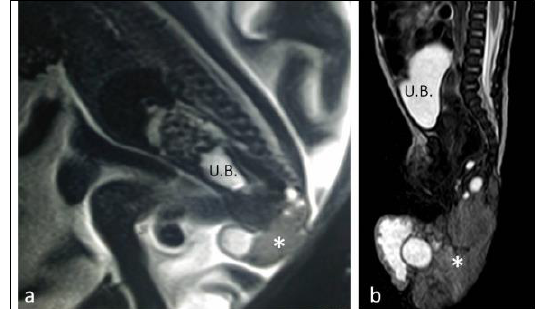
Figure 1: Ante-natal diagnosis of SCT. a) ante-natal MRI (22 weeks gestation) showing a mass (*) arising from the caudal end of the fetal vertebral column (SCT). b) Repeating the MRI postnataly at day 2 before surgical excision. U.B.: urinary